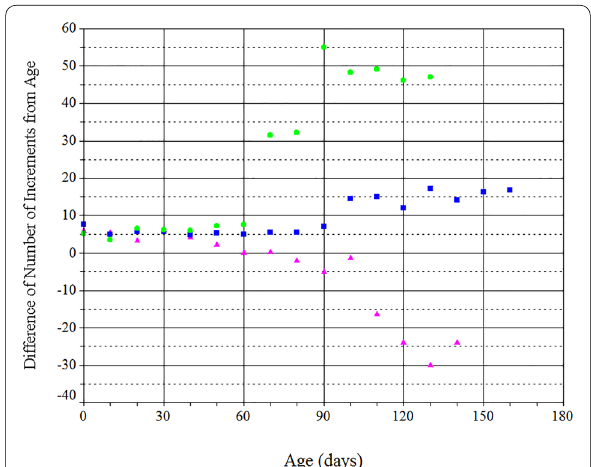
Fig. 4 Differences of number of increments from age (days), where maturity is from 60 days, (circle— Sepioteuthis lessoniana , rectangle— Sepia pharaonis , triangle— Sepiella inermis